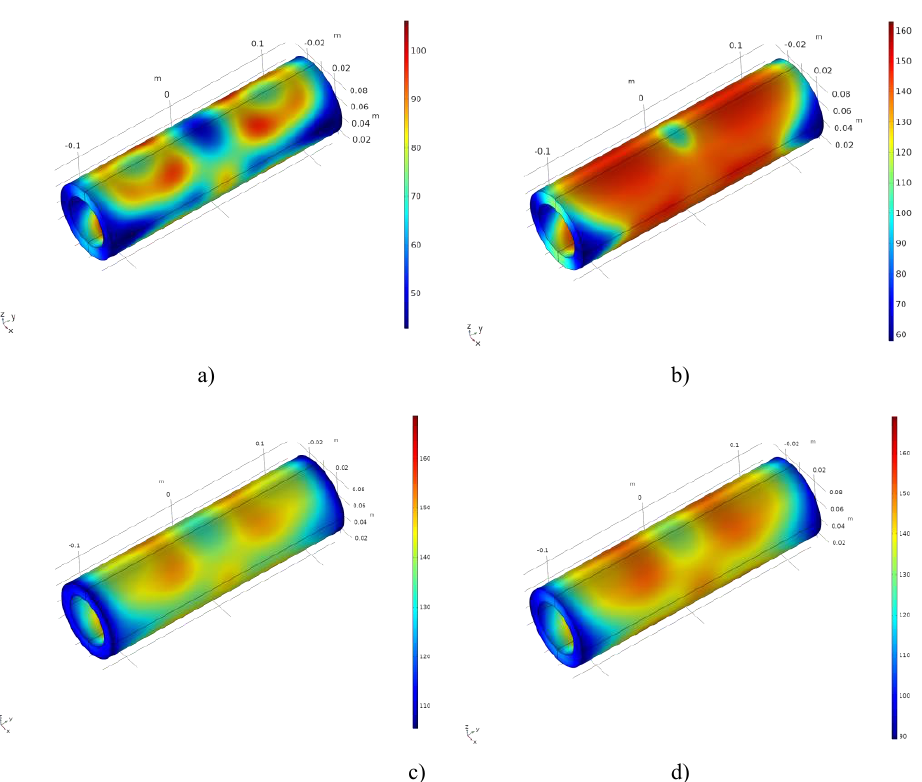
Fig. 5. The temperature field of the workpiece in the operating area of the microwave heating